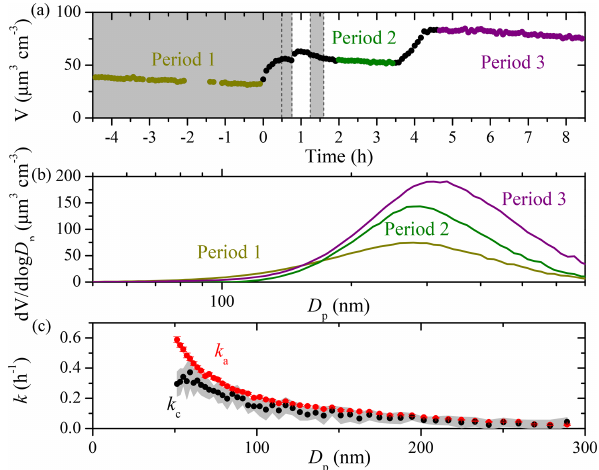
Figure 5. Particle-loss-corrected SOA mass concentration ( ρ SOA = 1 . 4µgm − 3 ) time series based on SMPS measurements using the size-independent k values (open symbols) and the size-dependent k(D p ) values (solid symbols) for Exp. 3; k 1 – k 3 were derived from the total mass concentration-based method (Eq. 2) when wall loss was the only process ( t 1 = − 4 . 5–0h; t 2 = 2–3.4h; t 3 = 4 . 7–8.4h). The k a (D p ) and the k c (D p ) profiles were derived from the two mod- els based on the SMPS-measured number concentration of the seed wall-loss periods. The shaded area indicates that the chamber was dark. The dashed lines mark the beginning and the end of bubbling HONO into the